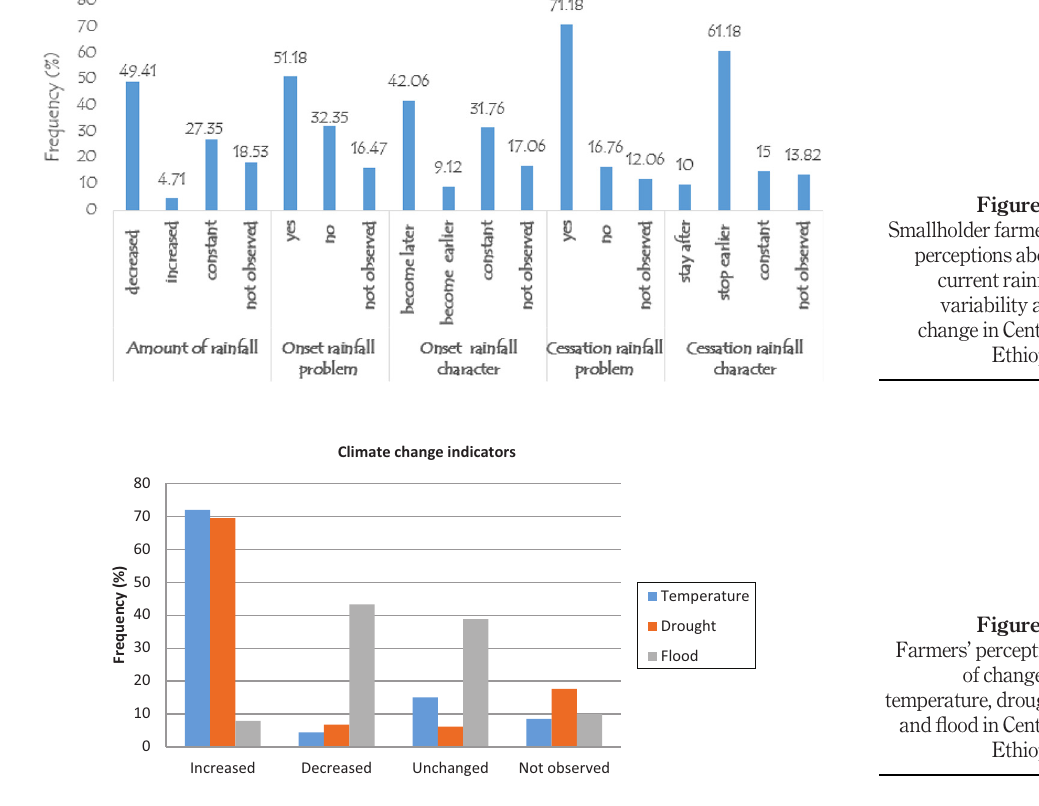
Figure 2. Smallholder farmers ’